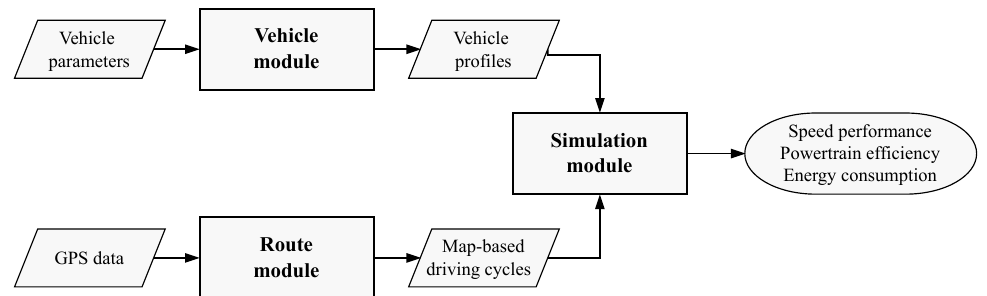
Figure 1. Flowchart presentation of the whole simulation